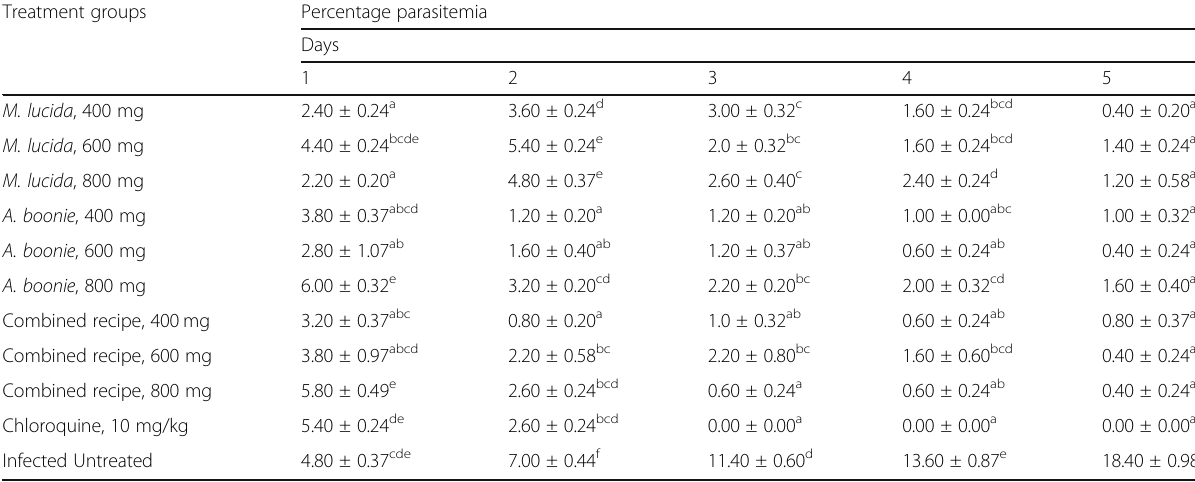
Table 3 Curative effect of Morinda lucida and Alstonia boonei plant extracts and chloroquine against P. berghei infection in mice for five consecutive days Treatment